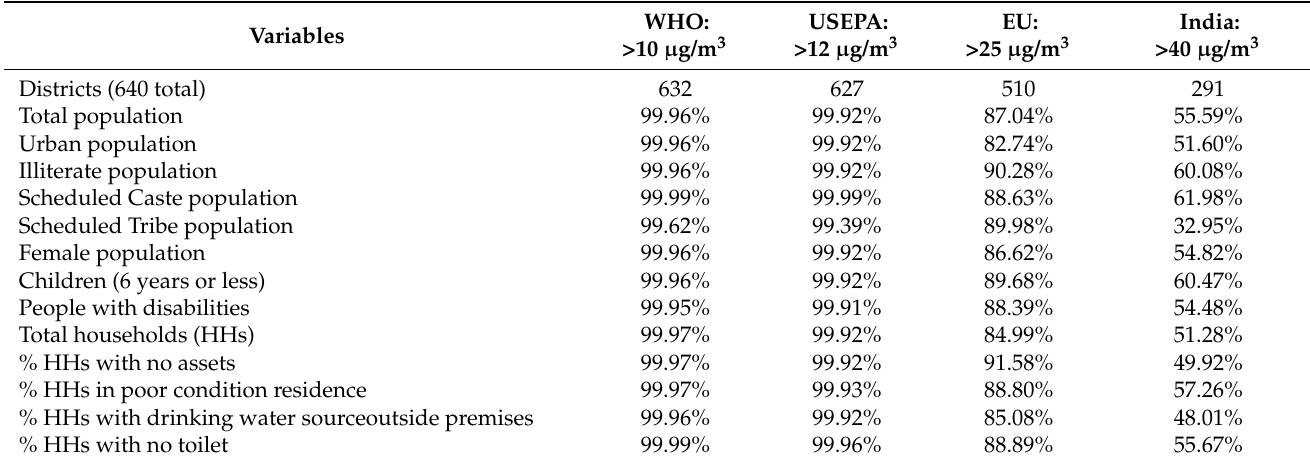
Figure 3. Distribution of 2016/2010 ratio of annual average PM 2.5 concentrations ( µ g/m 3 ) by district in India. We began our statistical analysis by estimating the population and household characteristics of districts where the average PM 2.5 pollution levels in 2010 exceeded international and national air quality standards. These results are summarized in Table 2. Table 2. Percentages of population and household subgroups in India where 2010 annual average PM 2.5 concentrations exceeded standards established by the World Health Organization (WHO), U.S. Environmental Protection Agency (USEPA), European Union (EU), and India.